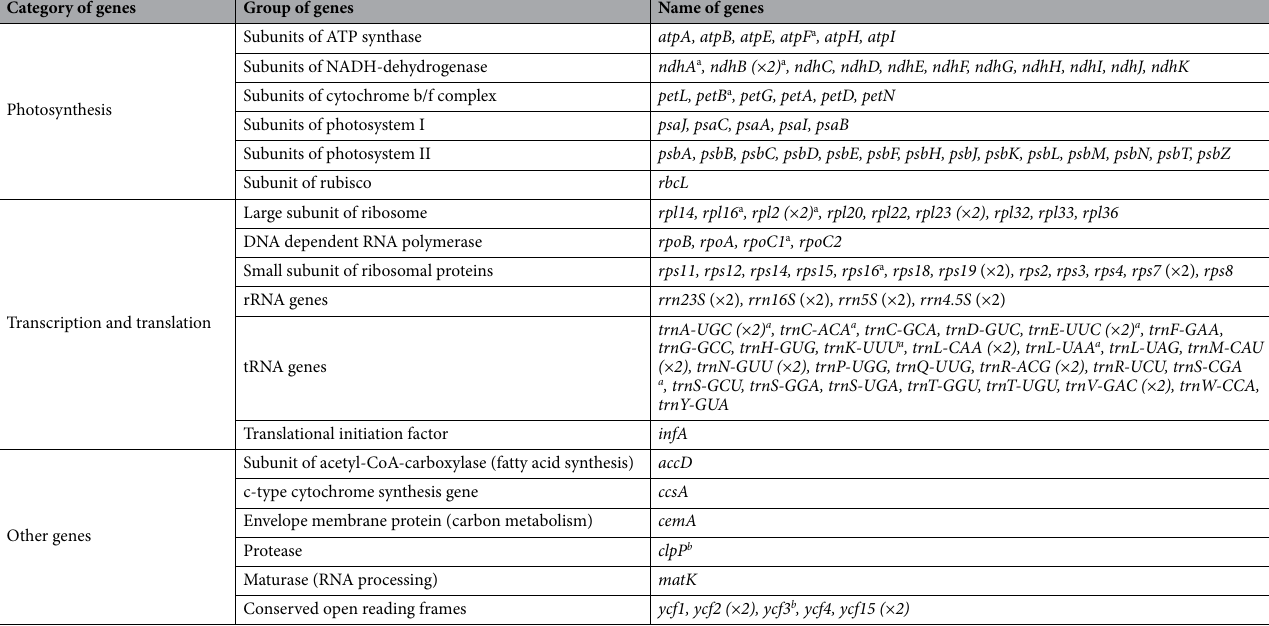
Table 2. Gene composition of A. megaphylla Hu chloroplast genome. Genes marked with the sign are the gene with a single (a) or double (b) introns and duplicated genes